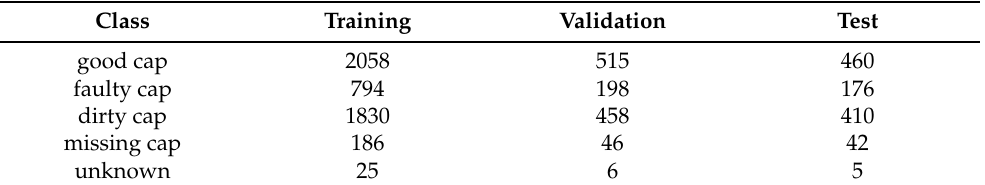
Table 1. Number of samples in each subset of the dataset.